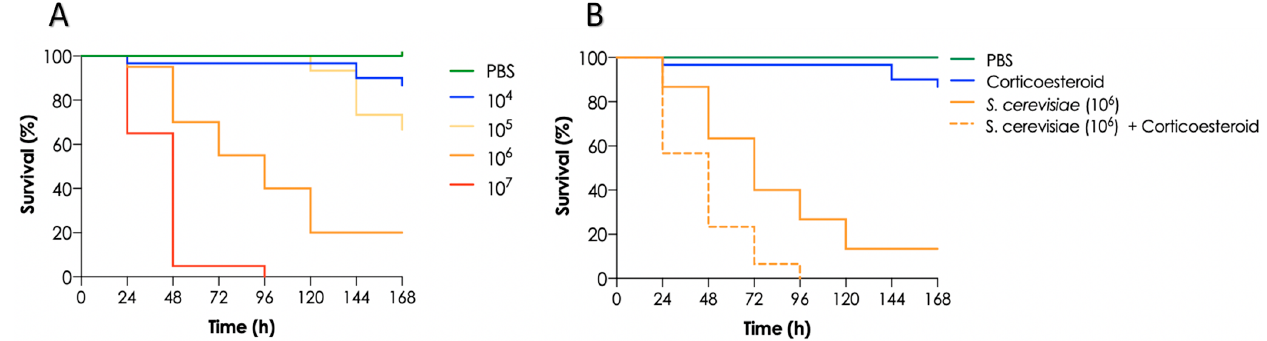
Figure 6. Survival curves of T. molitor larvae infected with different inoculum sizes of S. cerevisiae HUPE-Sc1 strain (10 4 , 10 5 , 10 6 and 10 7 fungi/larvae) ( A ) and effect of the treatment with corticosteroids (100 µg) on larvae survival after injection of 10 6 fungi/larva ( B ). In both cases, groups of 10 larvae were infected with indicated systems, repeated three times and pooled together in order to build survival curves with 30 animals. Negative controls were composed by T. molitor larvae injected only with PBS or corticosteroids (100 µg).